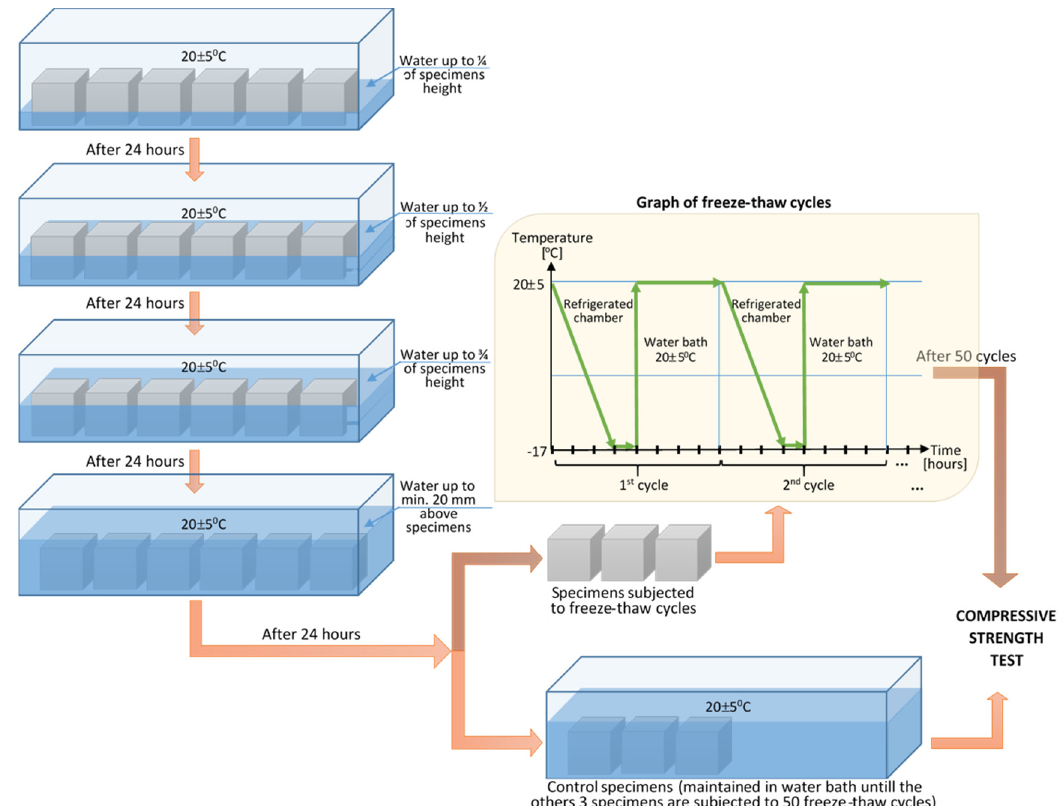
Figure 4. Method applied for freeze-thaw resistance determination.